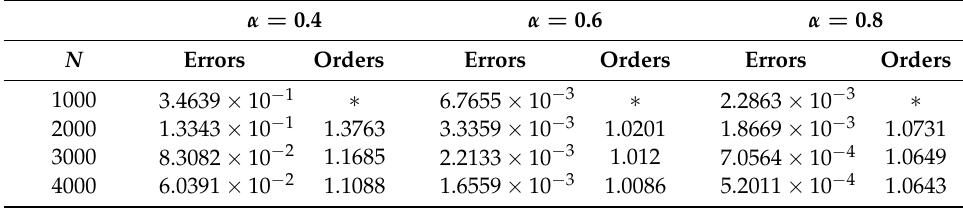
Table 1. Errors and orders in temporal direction for Scheme I (Example 1).